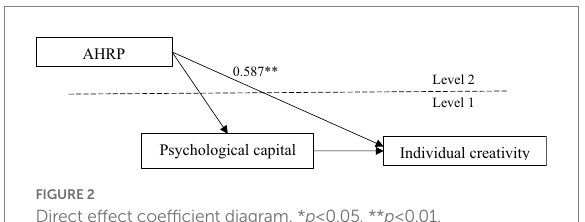
FIGURE 2 Direct effect coefficient diagram. * p < 0.05, ** p < 0.01.